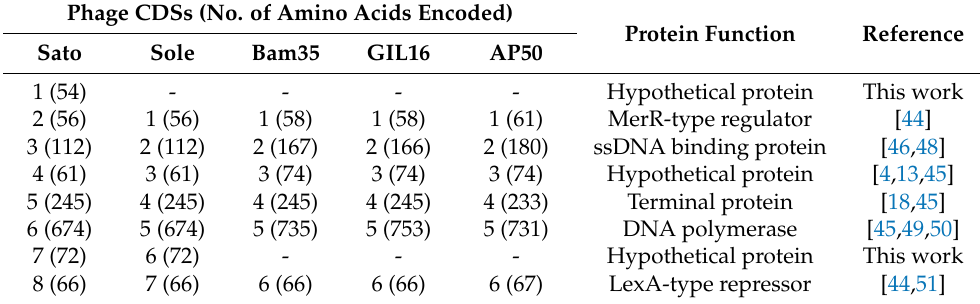
Table 1. Comparison of CDSs encoded in the gene regulation-genome replication module of Sato and Sole to those of other reference betatectiviruses.